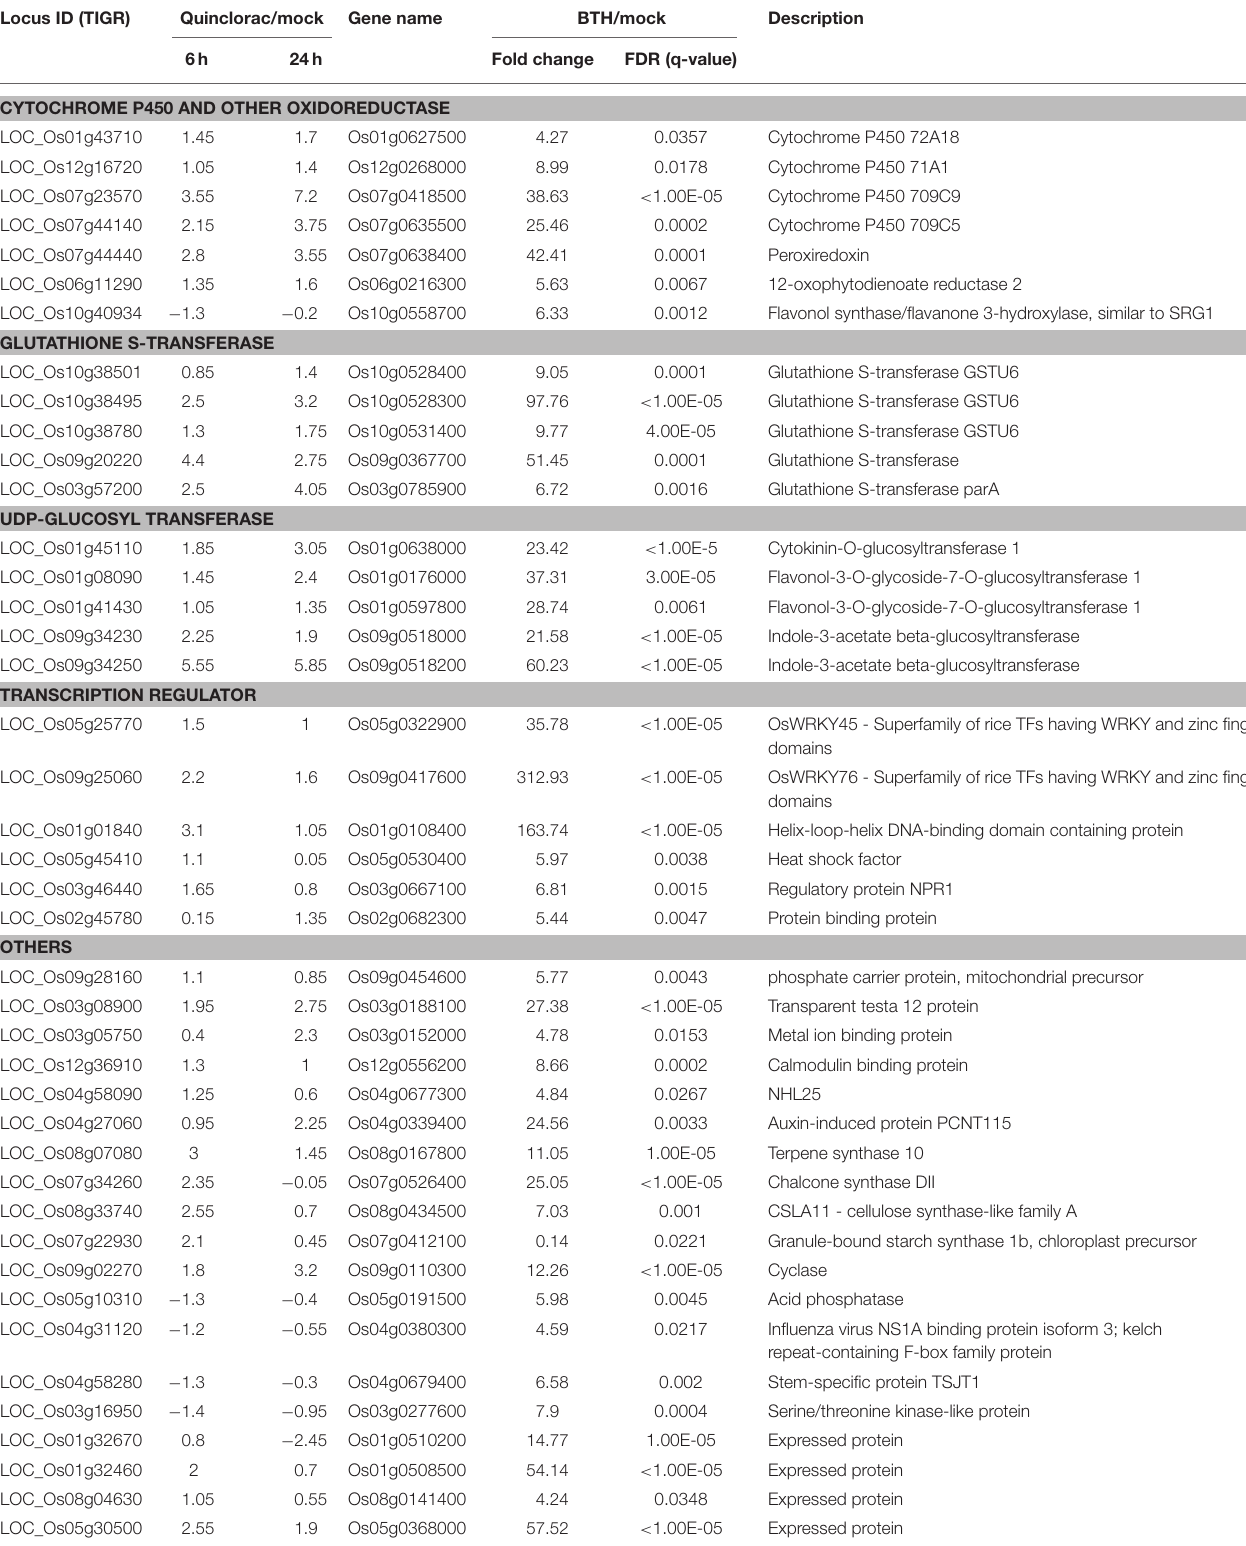
TABLE 3 | List of selected rice genes responded to both quinclorac and bentazone treatment. Locus ID